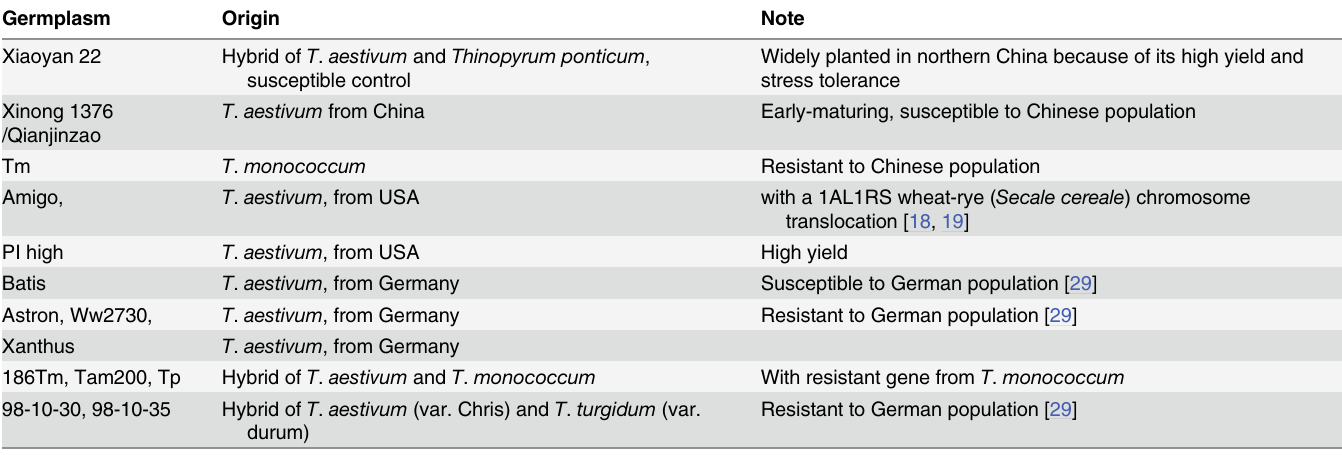
Table 1. List of wheat